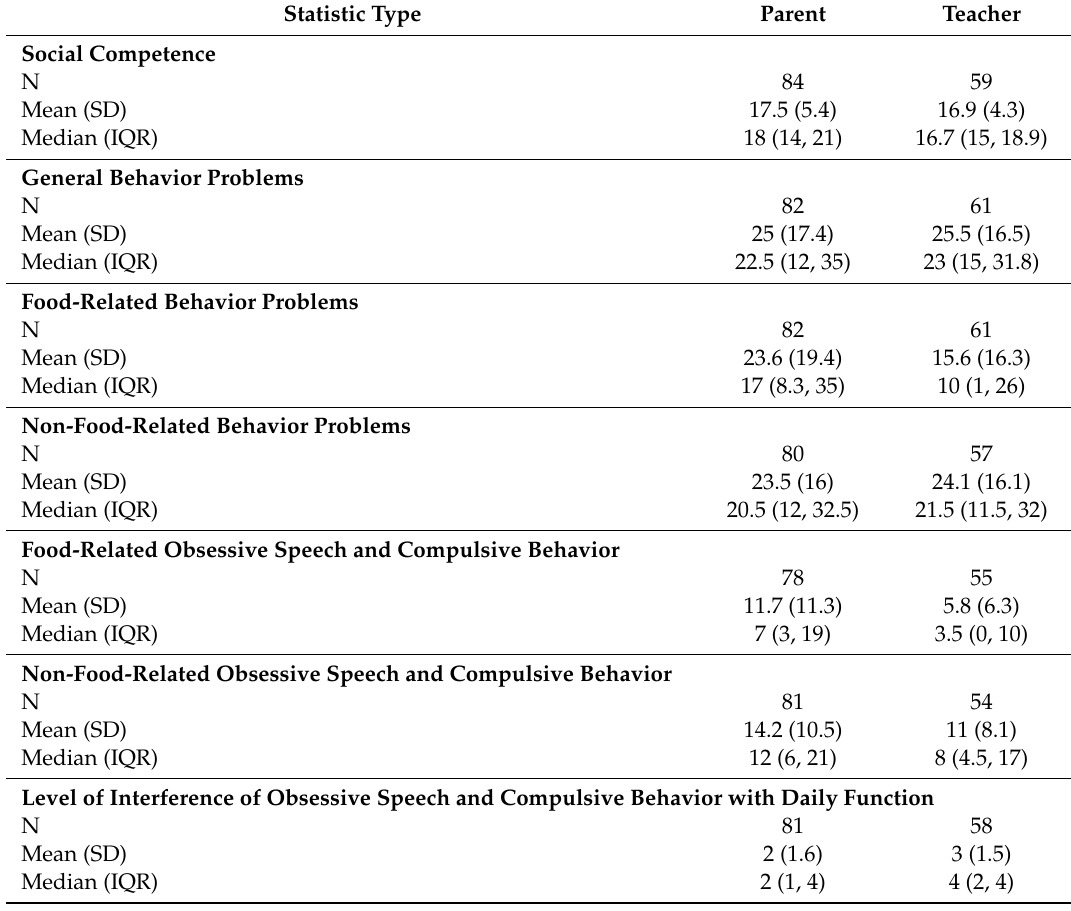
Table 2. Raw Global Assessment of Individual’s Behavior (GAIB) Subscale